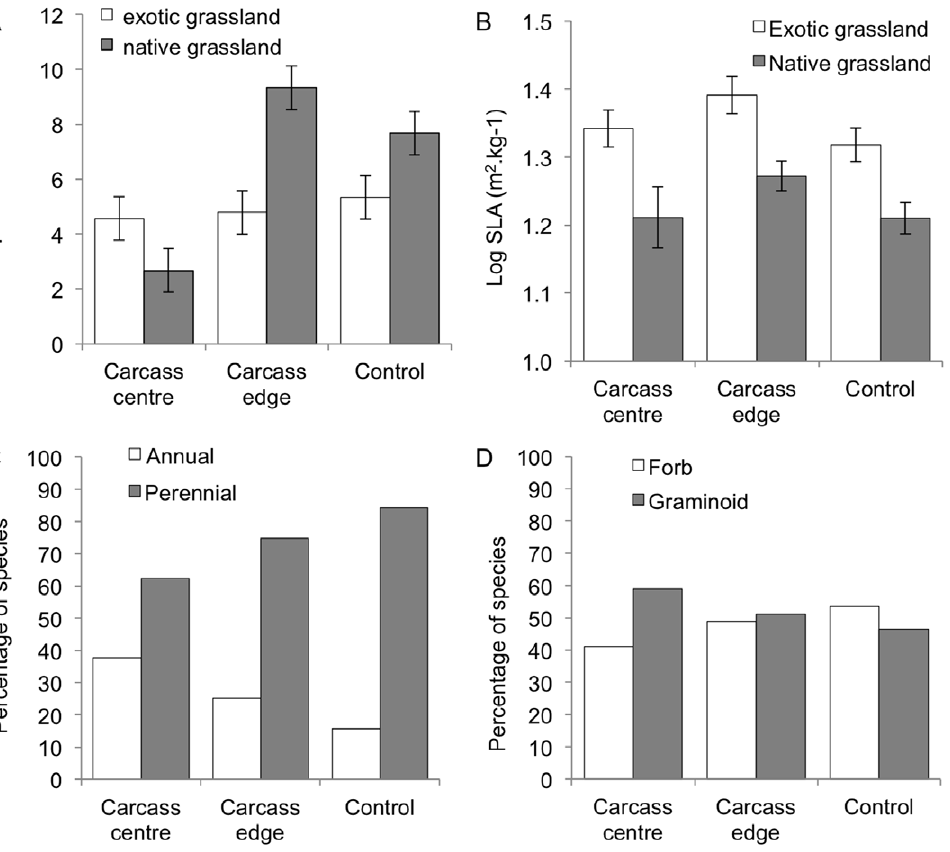
Figure 2. Differences in plant species richness and traits between carcass centre, carcass edge, and control sites. (a) Species richness of plants species in exotic grassland compared with native grassland. (b) Specific leaf area of plants in exotic grassland compared with native grassland. (c) Percentage of annuals versus perennials. (d) Percentage of graminoids versus forbs. Error bars show mean 6 SE.